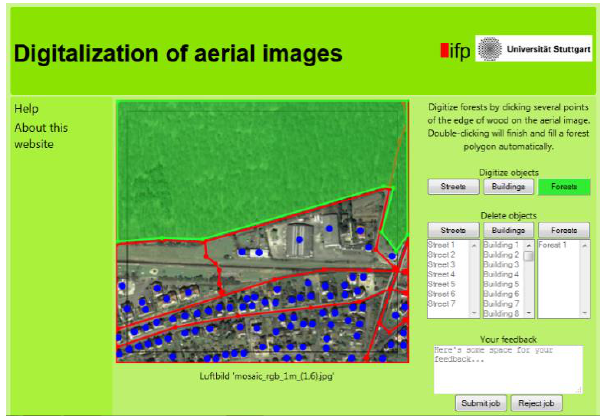
Figure 1. Graphical user interface for the crowd-based collection of spatial data.